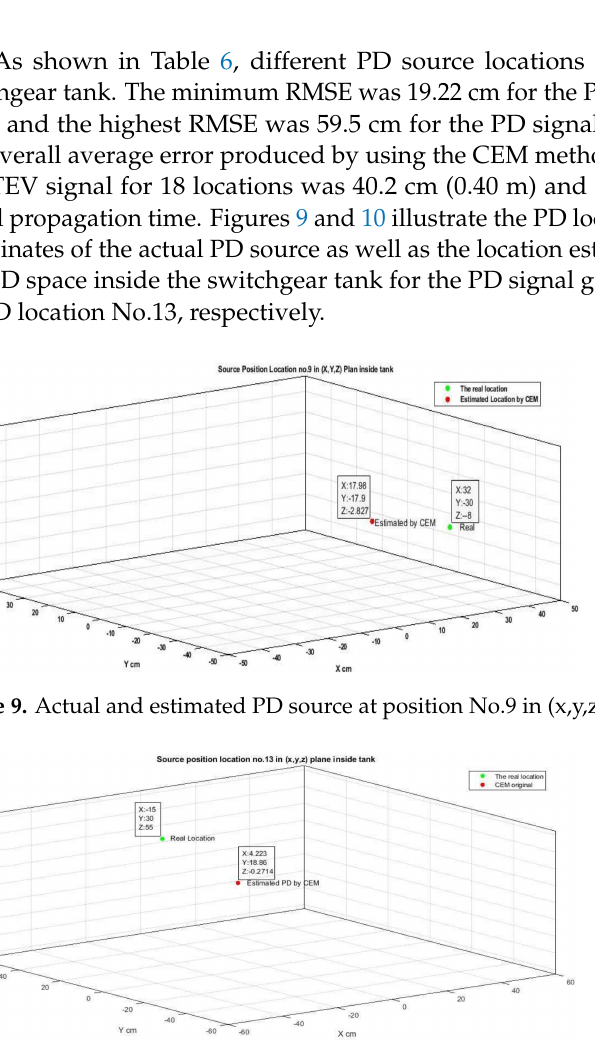
Figure 10. Actual and estimated PD source at position No.13 in (x,y,z)